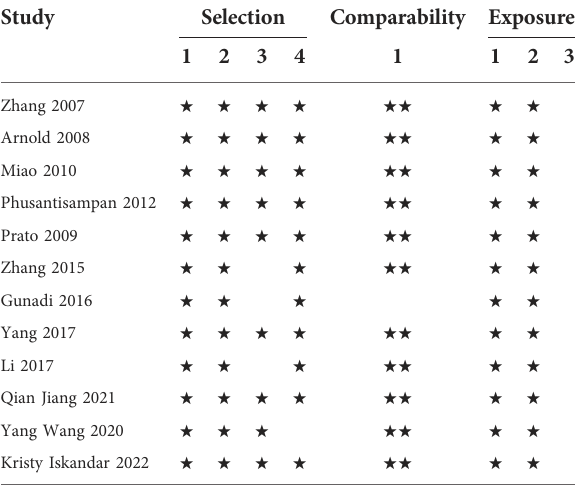
TABLE 2 Newcastle – Ottawa scale (NOS) scores for the studies included in the meta-analysis. Study Selection